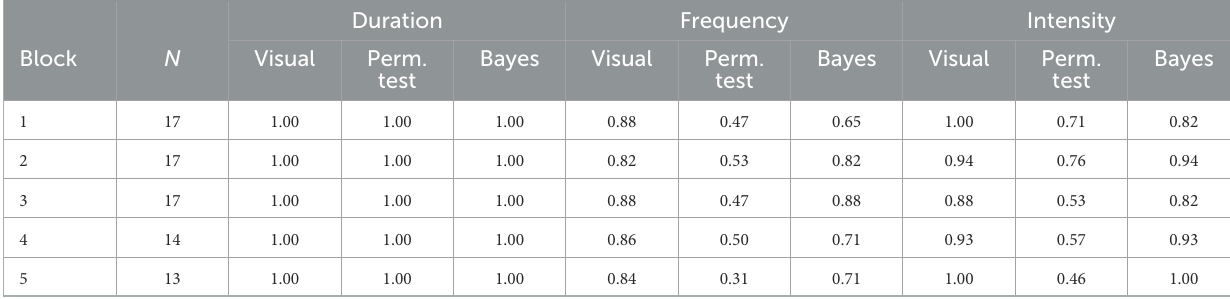
TABLE 2 Proportion of healthy controls showing evidence of MMN in each block.